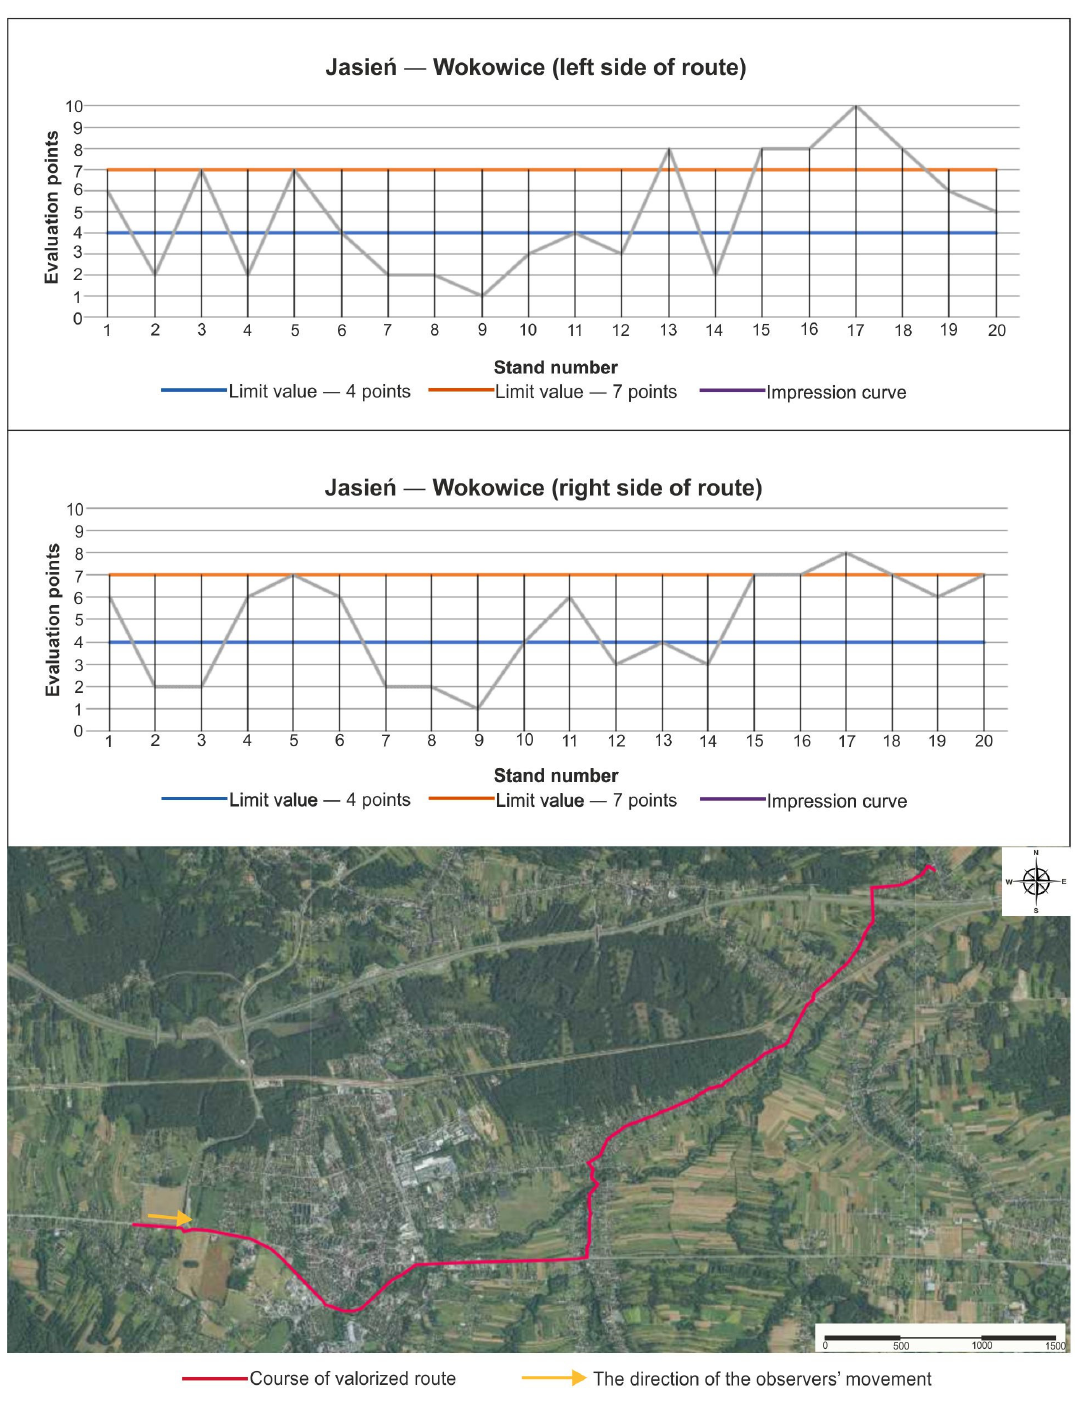
Figure 9. Impression curves for the Jasie´n—Wokowice route (Commune of